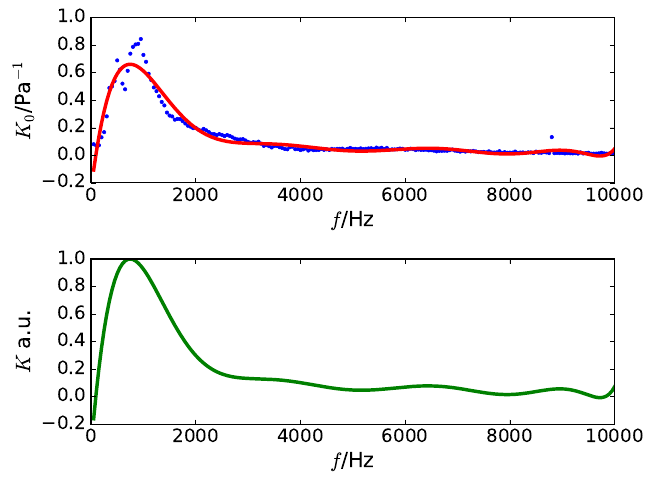
Figure 1. Example of the sensitivity calculation of a